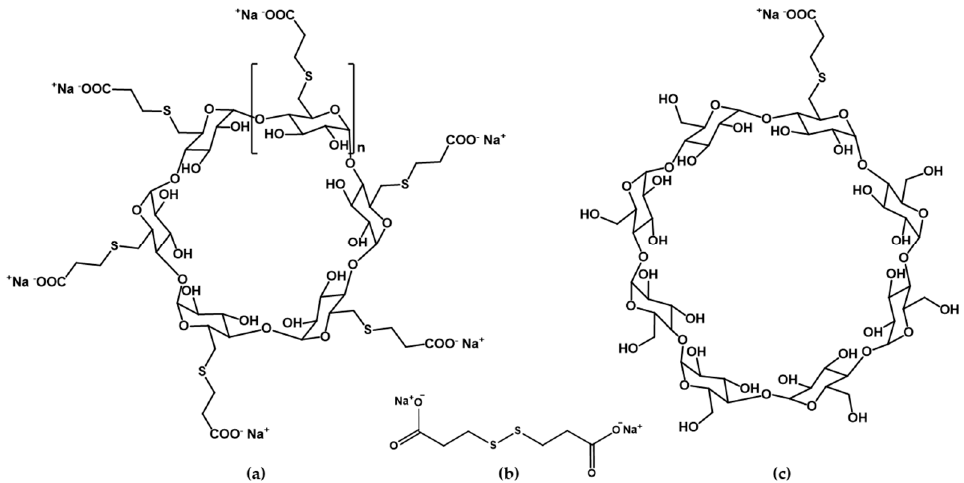
Figure 1. ( a ) Structures of sualphadex (Su α -CD, n = 1), subetadex (Su β -CD, n = 2) and sugammadex (Su γ -CD, n = 3); ( b ) structure of 3,3 ′ -dithiodipropionic acid (DTDPA); ( c ) structure of mono-sugammadex (mono-Su γ -CD).